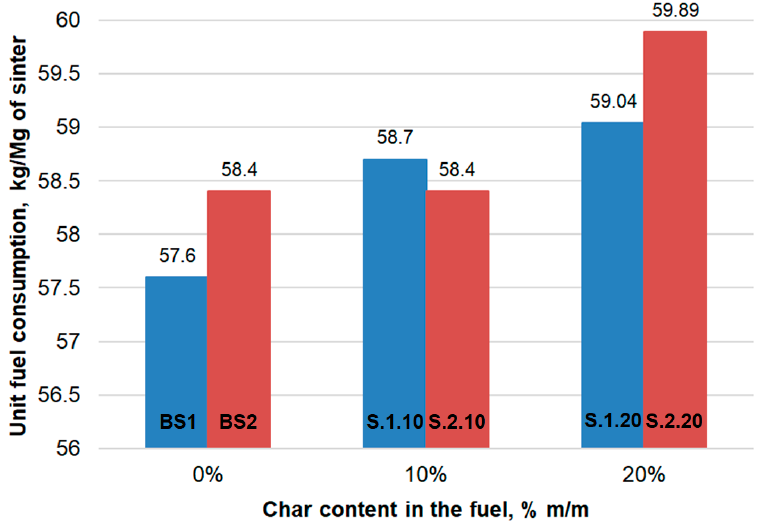
Figure 4. Unit fuel consumption depending on the content of char from waste tires in the fuel. A sinter with a particle size greater than 5 mm is an input for the blast furnace process. In this research, the amount of this type of sinter was slightly lower when char was added than for the basic blend, as shown in Tables 5 and 6. For comparison, when char from biomass was added, the amount of particles > 5 mm was higher: 23,94–26,84 %m/m, depending on the biomass type [14]. For BM1 and BM2, the amount of sinter generated was 107.4 and 106.2 kg, respectively. In the case of a 10 %m/m addition of char, the mass of the generated sinter was 106.6 (for S1.10) and 105.5 kg (for S2.10). In the case of 20 %m/m addition of char, the sinter mass with particles > 5 mm was 105.5 (for S1.20) and 102.8 kg (for S2.20).